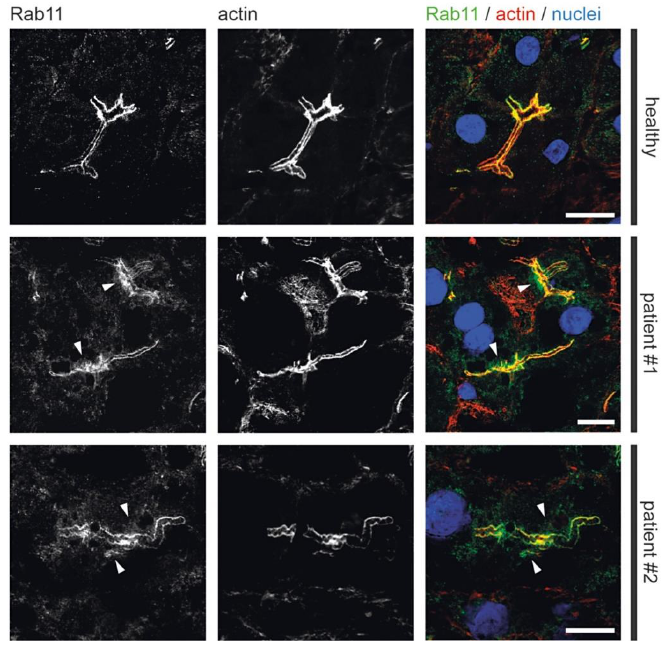
Figure 6. Localization of Rab11 in MYO5B-PFIC hepatocytes . IF of hepatocytes from patient #1 and #2 show subapical accumulation of Rab11 (arrow-heads) compared to healthy controls. Bile canaliculus with microvilli indicated by actin staining; scale bars = 5 µm.